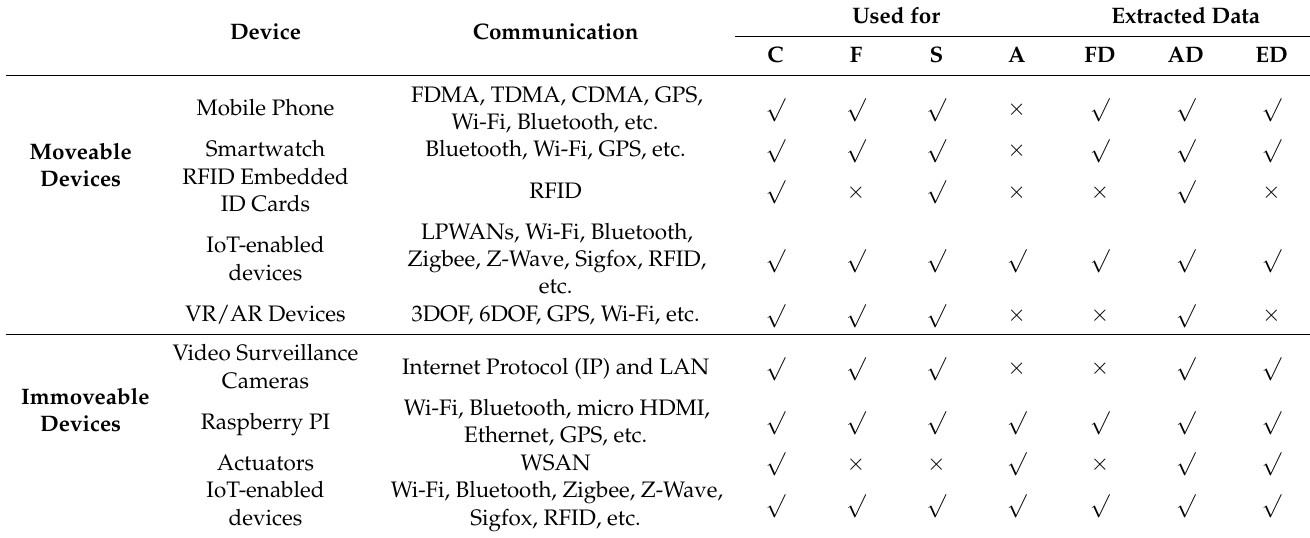
Table 2. Moveable and immoveable devices are used in an Education 4.0 environment.